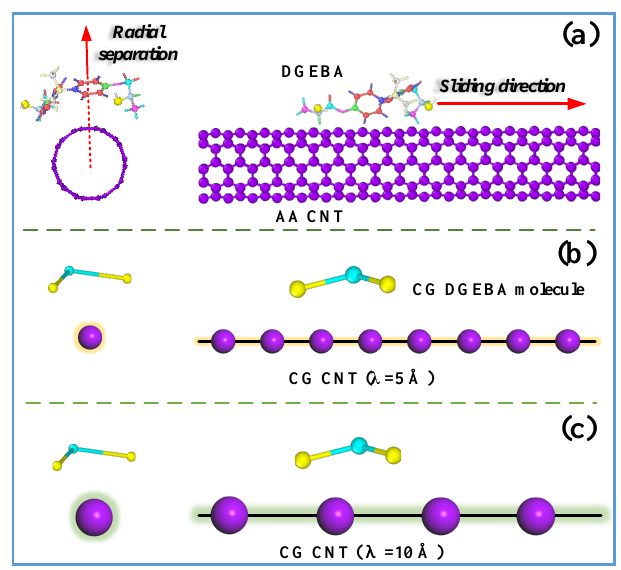
Figure 2. Illustration of adopted strategy “monomer separation response” for evaluating the interface load transfer of CNT/epoxy nanocomposites: ( a ) all-atomistic (AA) system, ( b ) coarse grained (CG) model with λ = 5 Å, and ( c ) CG model with λ = 10 Å. The “monomer separation response” includes radial opening simulation which is done by separating a DGEBA molecule from the (5,5) CNT along its radial direction, and axial sliding mode separation simulation which is done by forcing the DGEBA molecule slides on the CNT surface along its axial